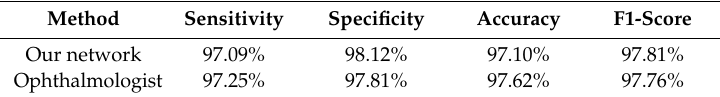
Table 4. Comparison of classifications, benchmarked against ophthalmic pathologist.